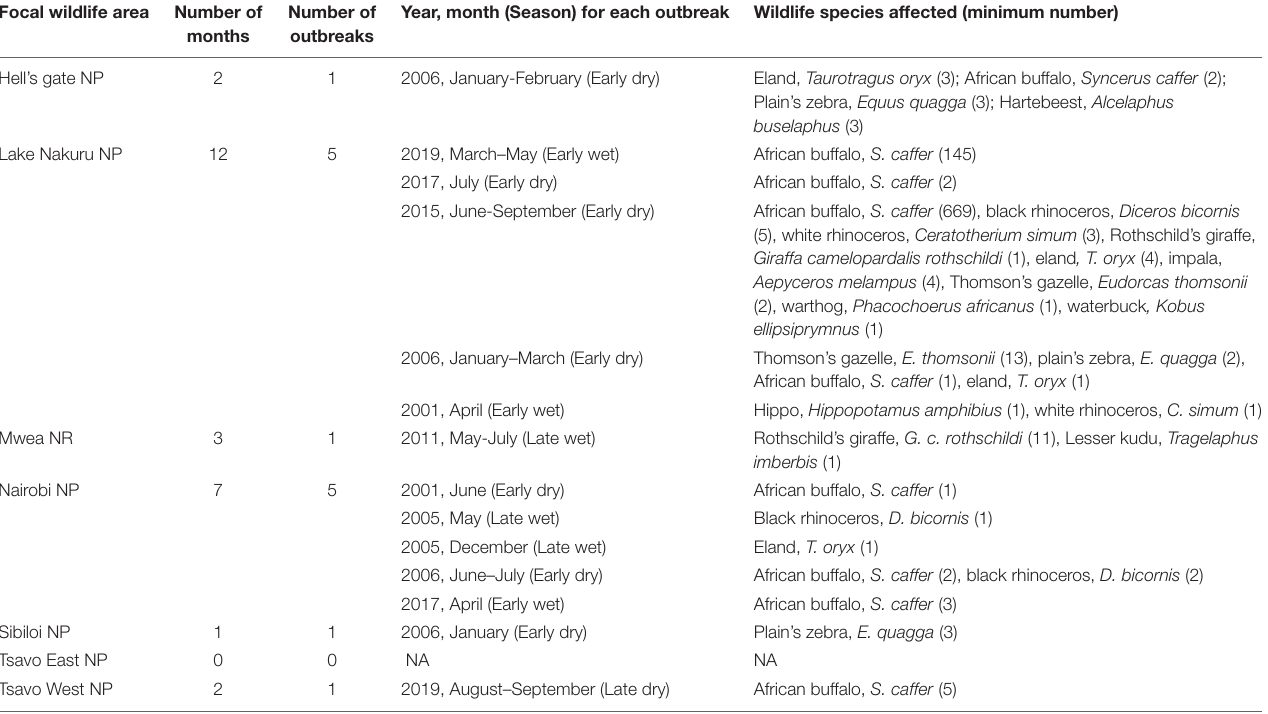
TABLE 2 | Anthrax outbreaks from 2000 to 2019 in selected wildlife areas (NP, National Park and NR, National Reserve) in Kenya. Focal wildlife area Number of months